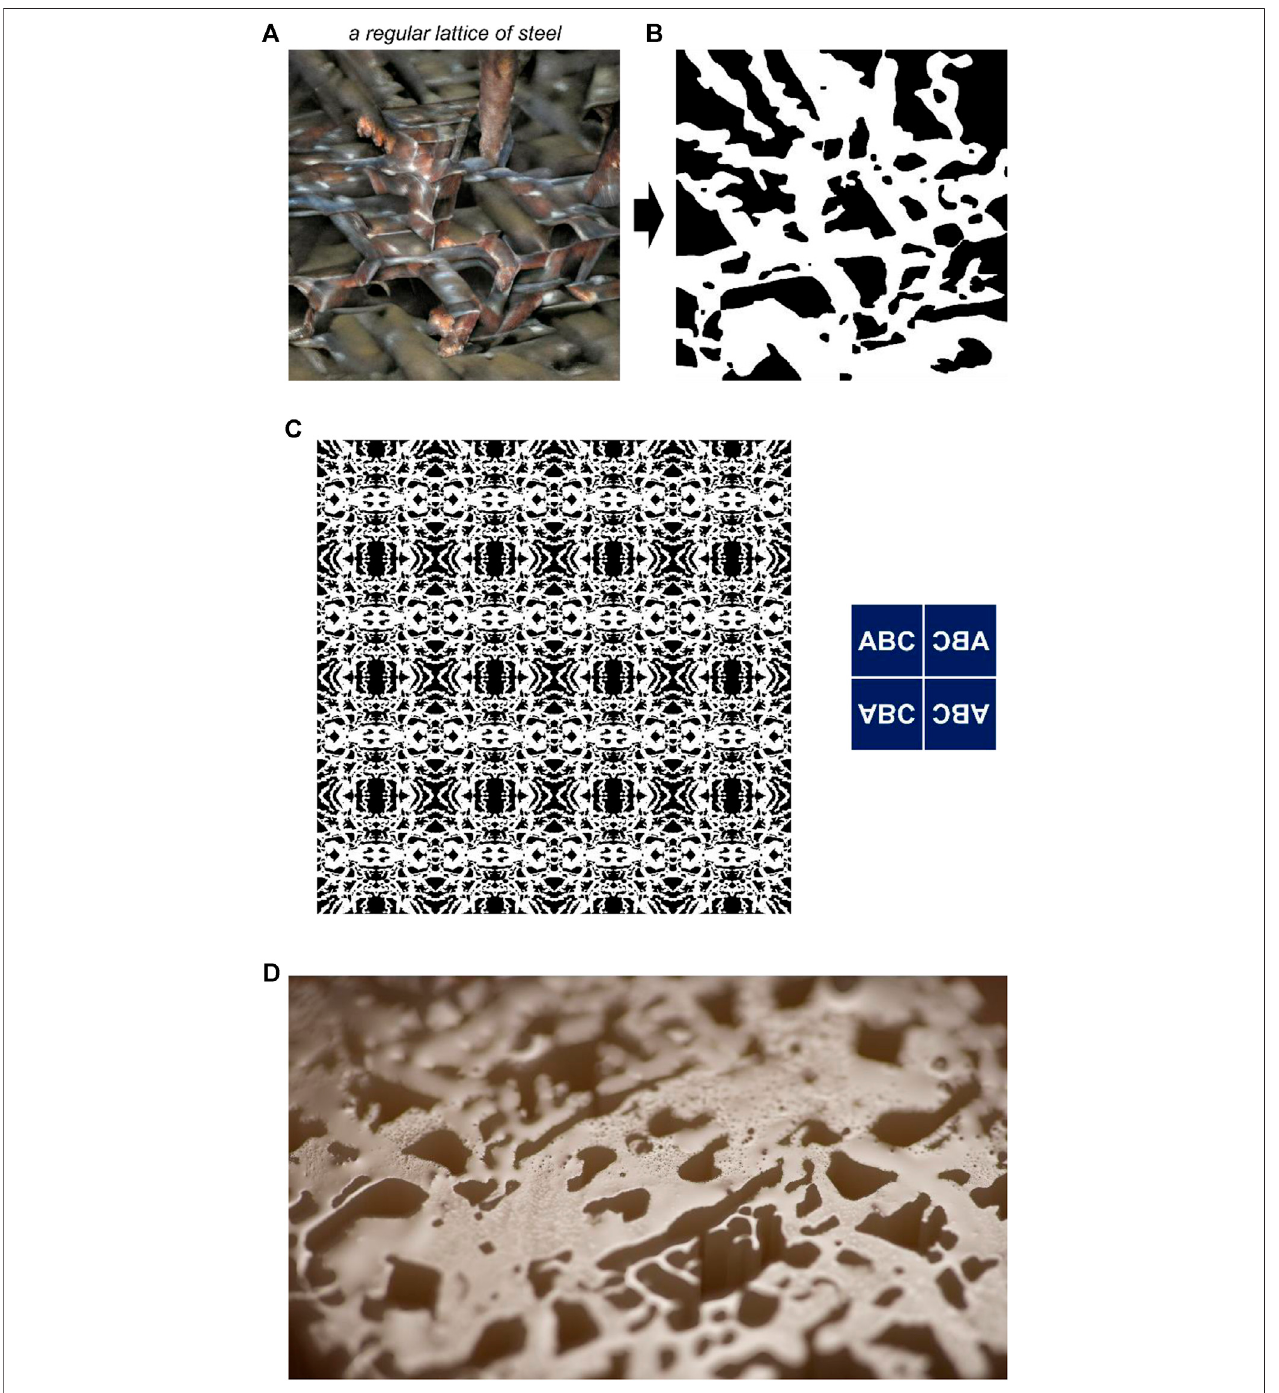
FIGURE4| Text-based image generation (A) ,processingintoablack-and-whitemaskusingsmoothingoperations (B) ,and generationofperiodicmaterialdesign using geometric operations ( fi rst: horizontal fl ip, then vertical fl ip of the original and initially fl ipped design, yielding a periodic structure — see inset on the right with letters “ ABC ” ) (C) . Panel (D) shows a close-up view of the 3D printed material. More 3D printed structures are shown in Figure 6 .